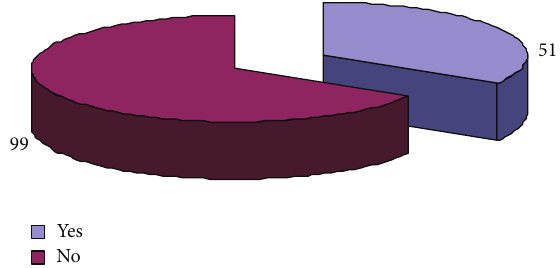
Figure 21: Showing the distribution of patients according to complaints of pale skin